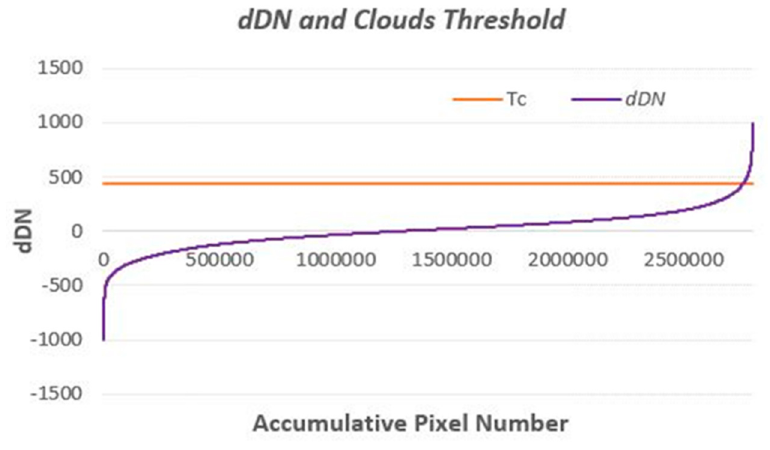
Figure 2. A typical sorted 𝑑𝐷𝑁 (cid:3030) and its accumulative pixel number distribution of a cloud contaminated